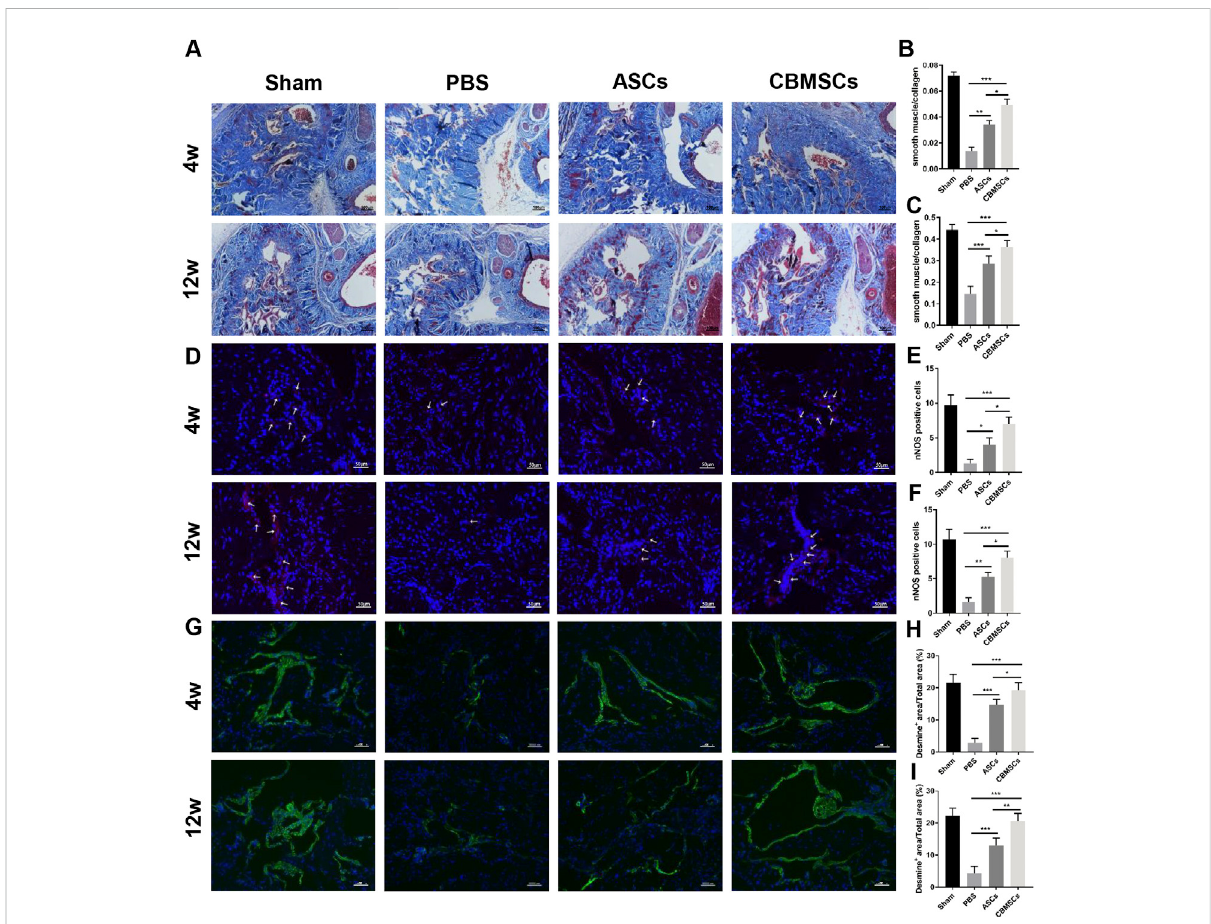
FIGURE 3 Masson trichrome staining and immuno fl uorescence staining of rat corpus cavernosum. (A) Representative images of Masson trichrome staining ofthecorpus cavernosum inapenile midshaft specimen. Magni fi cation: ×100.StatisticalanalysisofMassontrichrome stainingof rat corpus cavernosum at 4 weeks (B) and 12 weeks (C) . (D) Representative images of immuno fl uorescence staining of nNOS of rat corpus cavernosum. Red arrowheads: nNOS-positive area. Statistical analysis of immuno fl uorescence staining of nNOS at 4 weeks (E) and 12 weeks (F) after treatment. (G) Representativeimagesofimmuno fl uorescencestainingofdesminofratcorpuscavernosum.Statisticalanalysisofimmuno fl uorescencestaining of desmin at 4 weeks (H) and 12 weeks (I) . * p < 0.05, ** p < 0.01, and *** p <